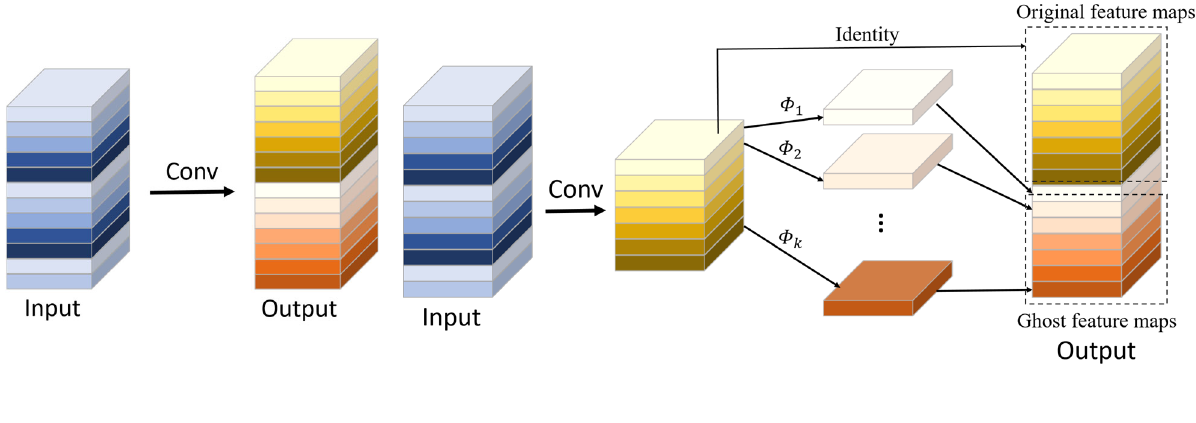
Figure 4. The convolution process of ordinary convolution and GhostConv.